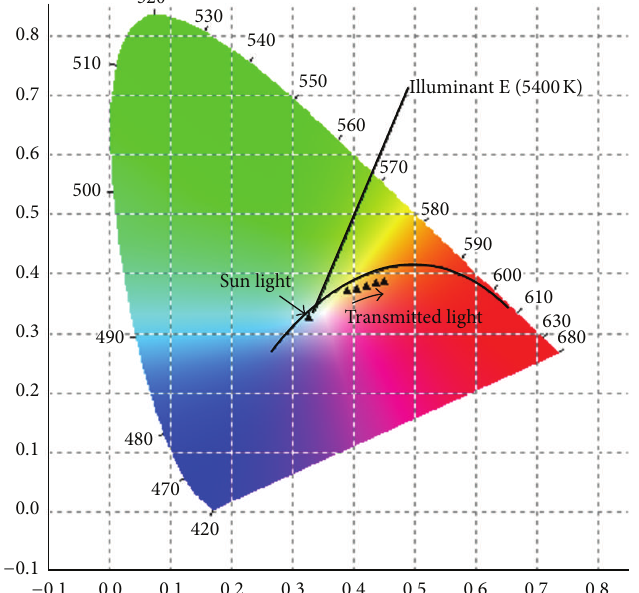
Figure 8: Simulation results of correlated color temperature variation of transmitted light for a 64 × 64 cm diffusive solar cell window with the increment of nanoparticle